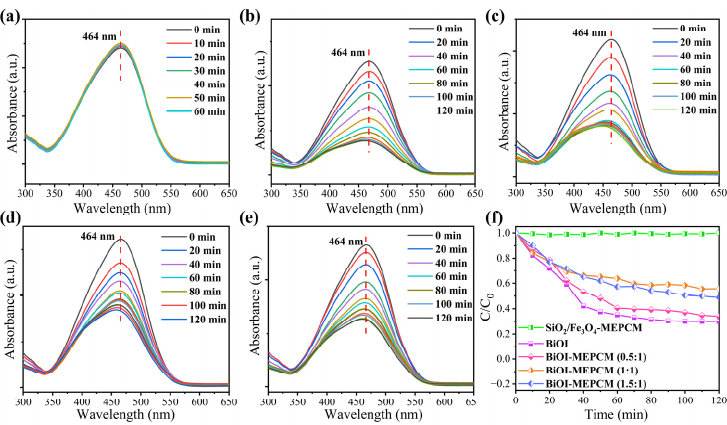
Figure 7. UV–vis absorption spectra of methyl orange during the photocatalytic process with ( a ) SiO 2 /Fe 3 O 4 -MEPCM, ( b ) BiOI, ( c ) BiOI-MEPCM (0.5:1), ( d ) BiOI-MEPCM (1:1), and ( e ) BiOI-MEPCM (1.5:1). ( f ) Photocatalytic degradation of methyl orange during the photocatalytic process with BiOI and phase-change microcapsules.